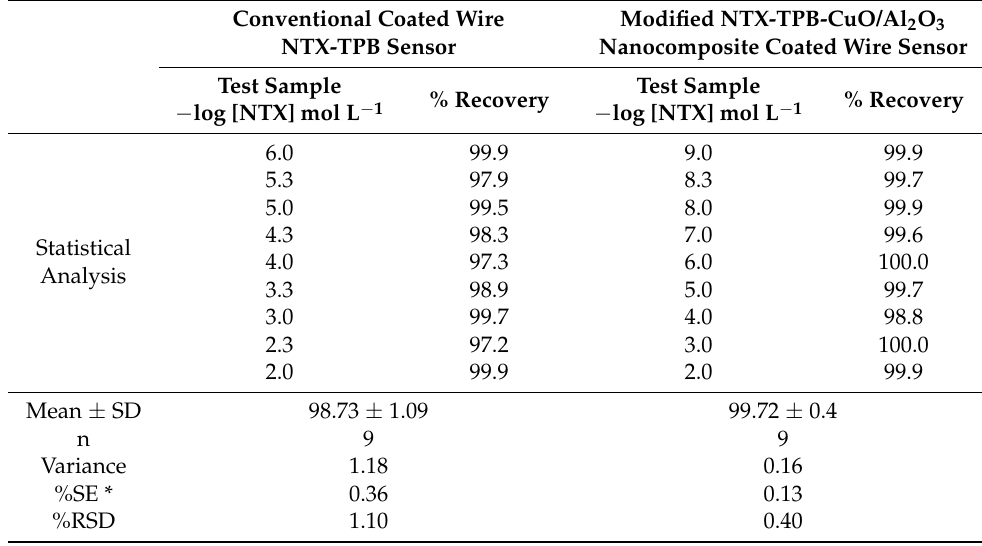
Table 4. The accuracy study for NTX estimation using the designed conventional coated